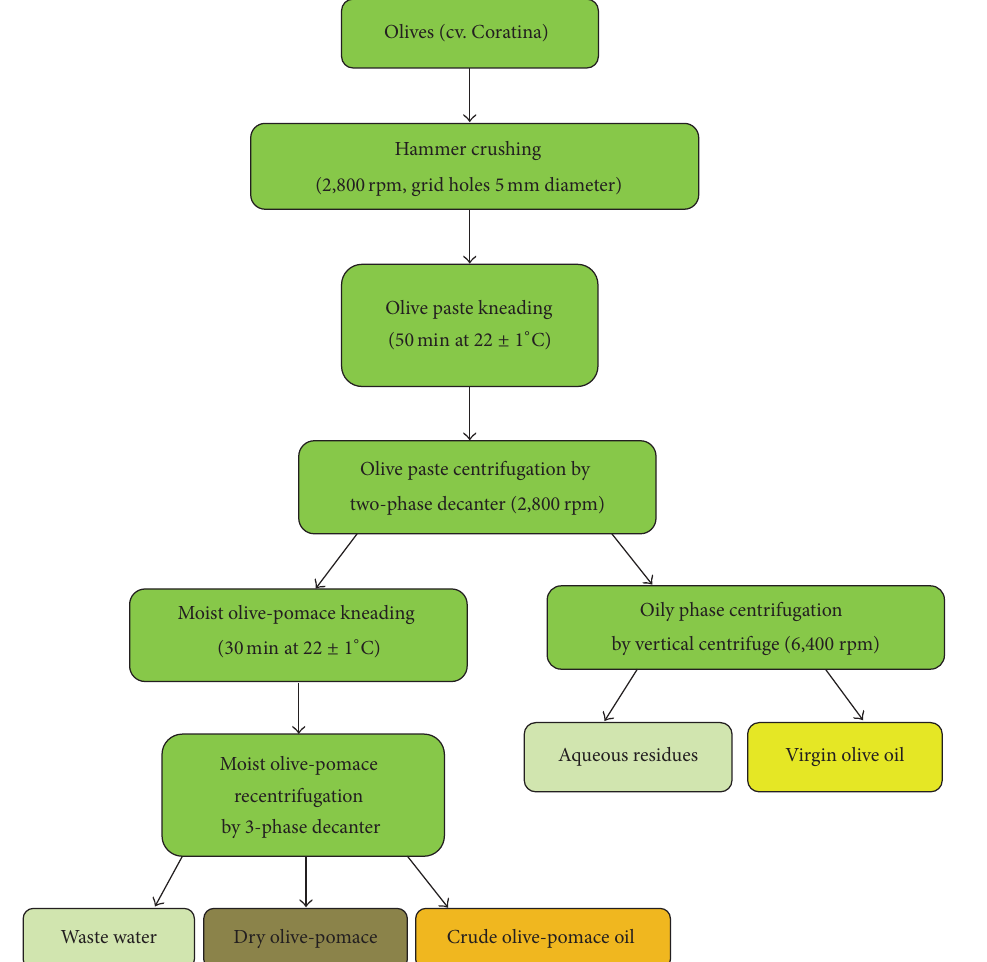
Figure 1: Flowchart of the productive process of virgin olive oil and crude olive-pomace